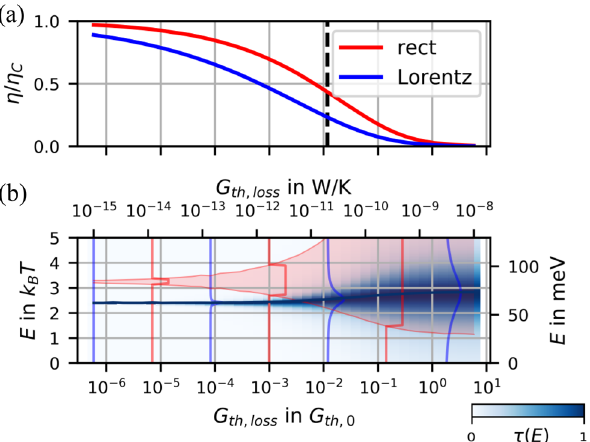
Figure 5. Efficiencies with optimized transmission functions. ( a ) Optimal values of the thermoelectric conversion efficiency for rectangular and Lorentz shaped transmission functions, plotted as a function of G th , loss . ( b ) The underlying optimized transmission functions.This plot is temperature invariant when choosing units 2 π 2 k 2 B T of k B T and the (electrical) thermal conductance quantum 36 G th ,0 = 3 h (left and lower scale). The right and upper scale denominate values at room temperature (T =